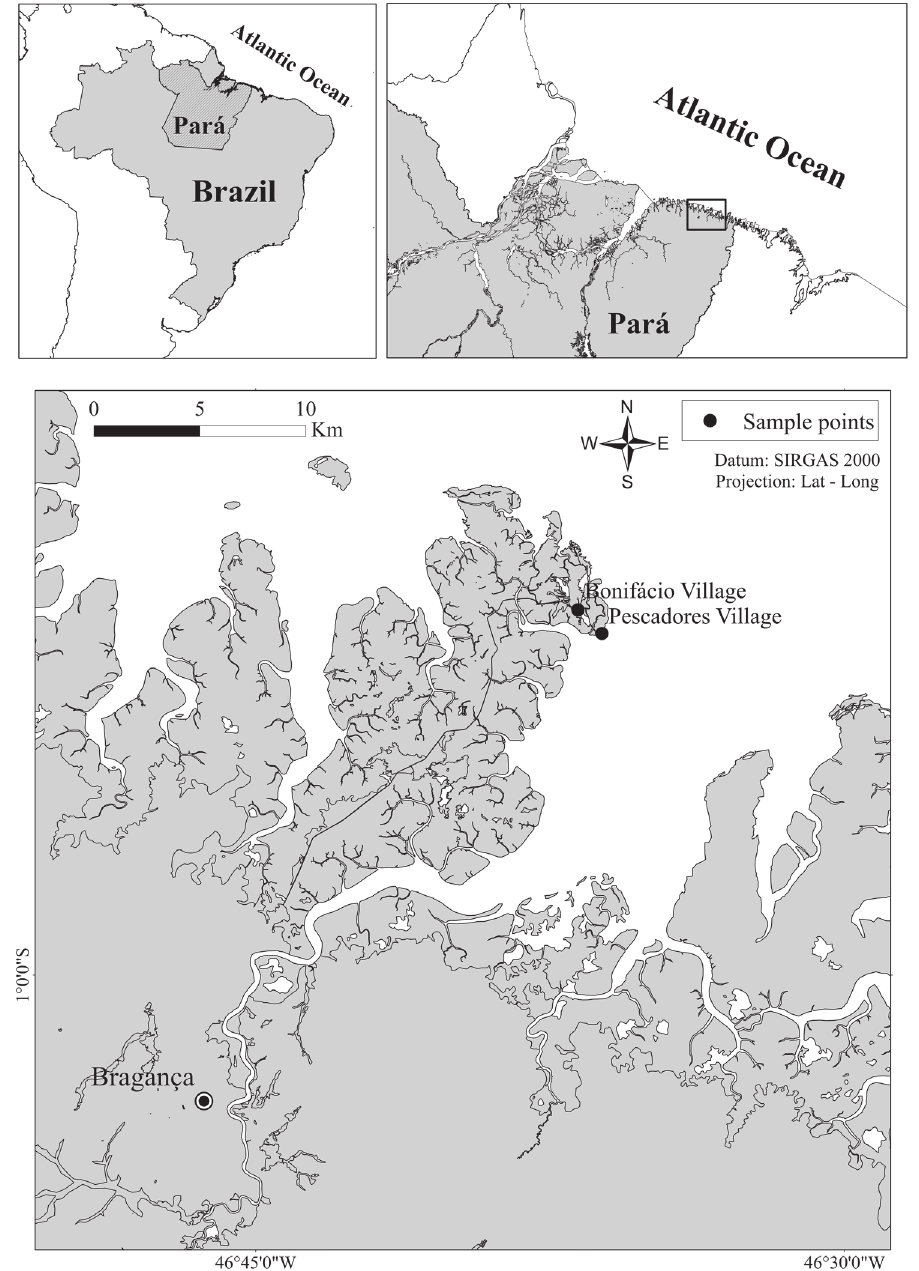
FIGURE 1 | Map of Ajuruteua Plateau, on the northern coast of Brazil, showing the two villages at which the ethnotaxonomic data on the fish of the family Mugilidae were collected in the present